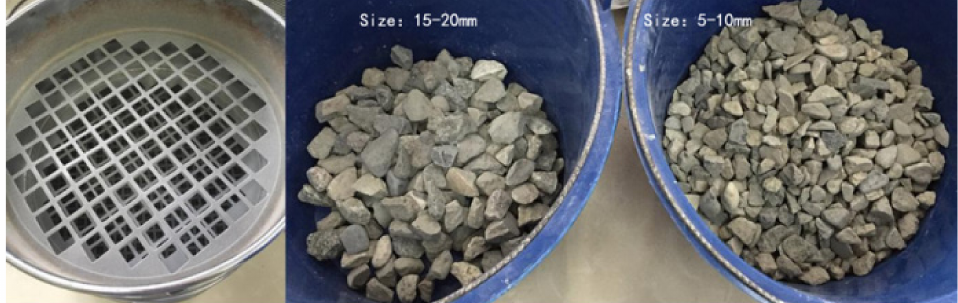
Figure 1. Photographs of sieves and appearance of aggregates.